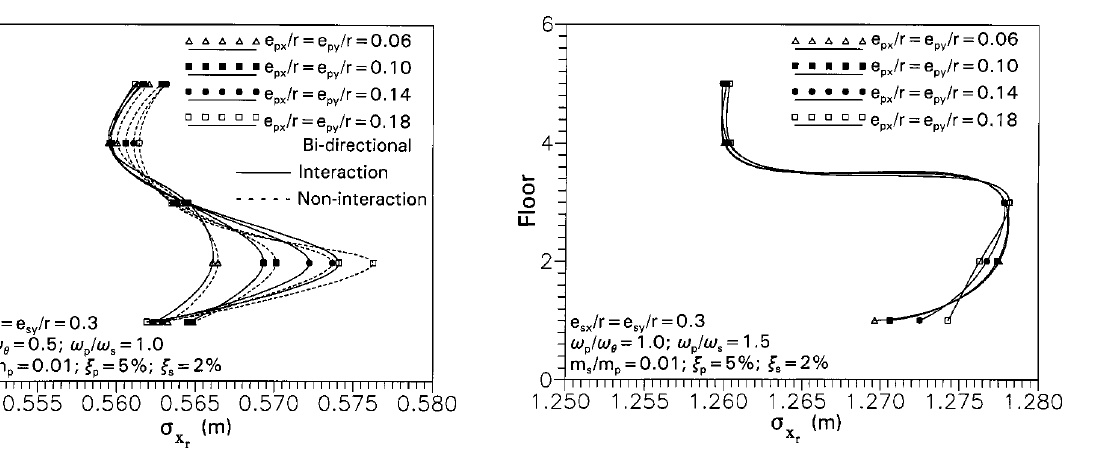
Fig. 4. Variation of (cid:27) x with storey height for various values of r e p x =r and e p y =r ; for m s =m p = 0.01; ! p =! s = 1.0; ! p =! (cid:18) = 0 : 5; e